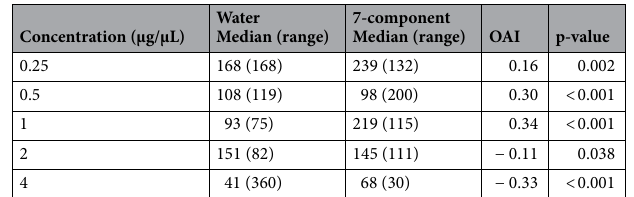
Table 1. Oviposition activity index (OAI) of 7-component blend at different concentrations.